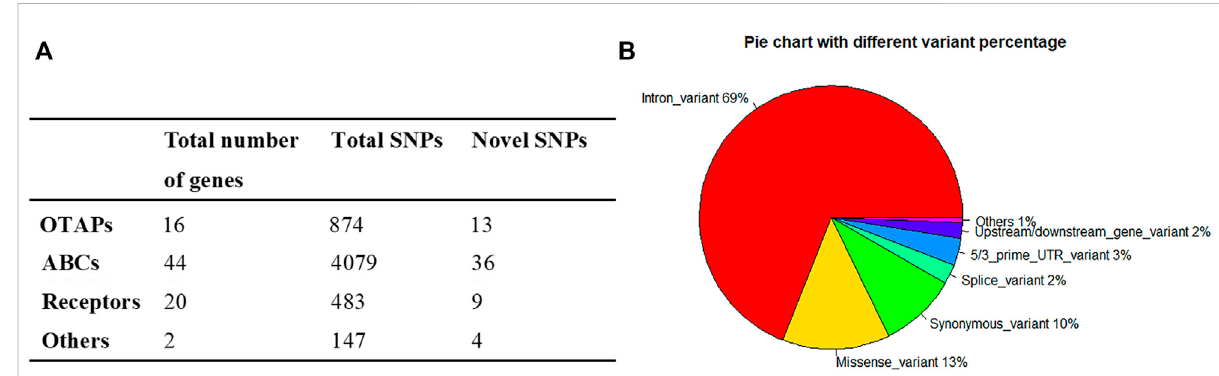
FIGURE 1 ThedistributionandnumbersofgenesandgeneticvariantsfromtheWESdataforICP. (A) Thetotalnumberofgenes,identi fi edSNPs,andnovel SNPs in OTAP genes, ABC genes, receptor genes, and other genes are summarized. (B) The percentage of the types of genetic variants in the four gene